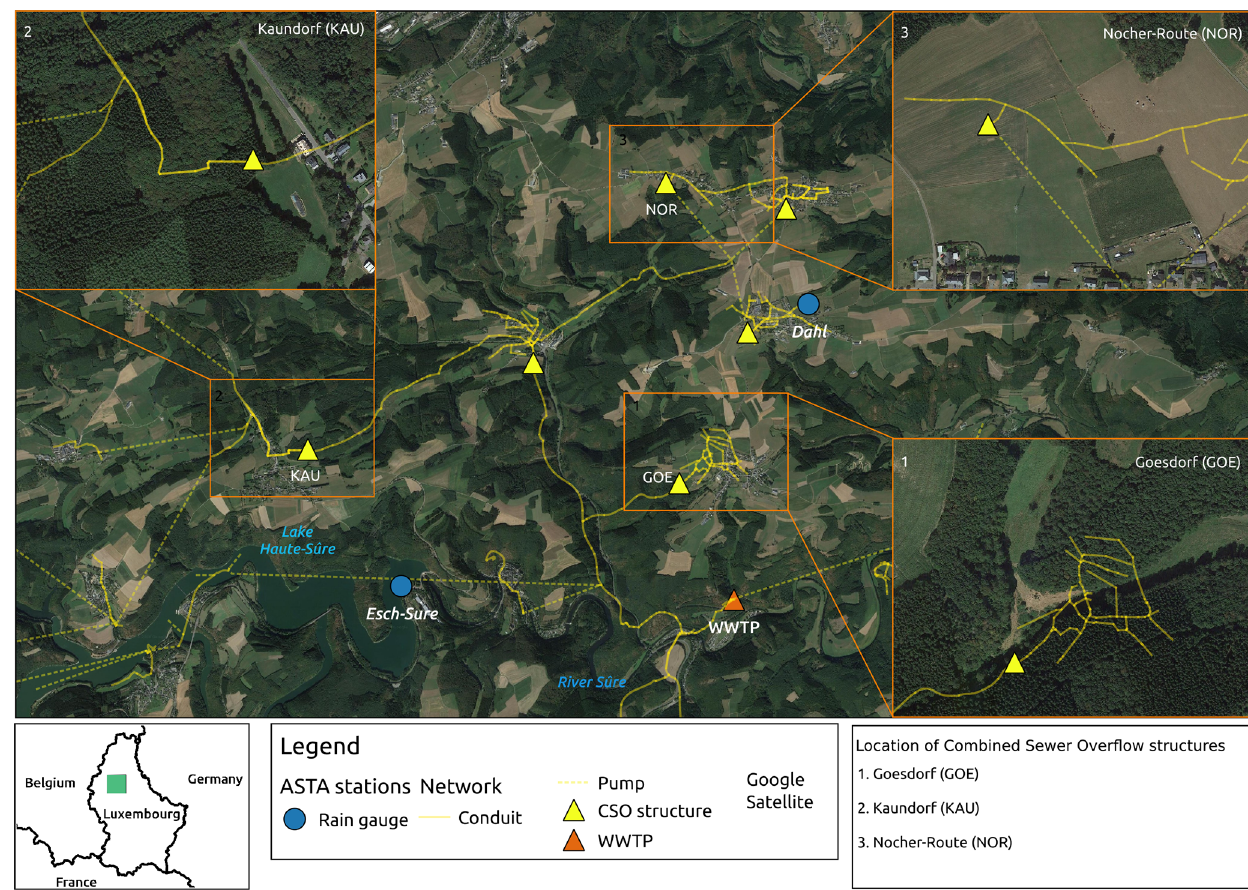
Figure 2. The three Haute-Sûre sub-catchments and locations of the combined sewer overflow (CSO) structures considered in this study. The background map is provided by © Google